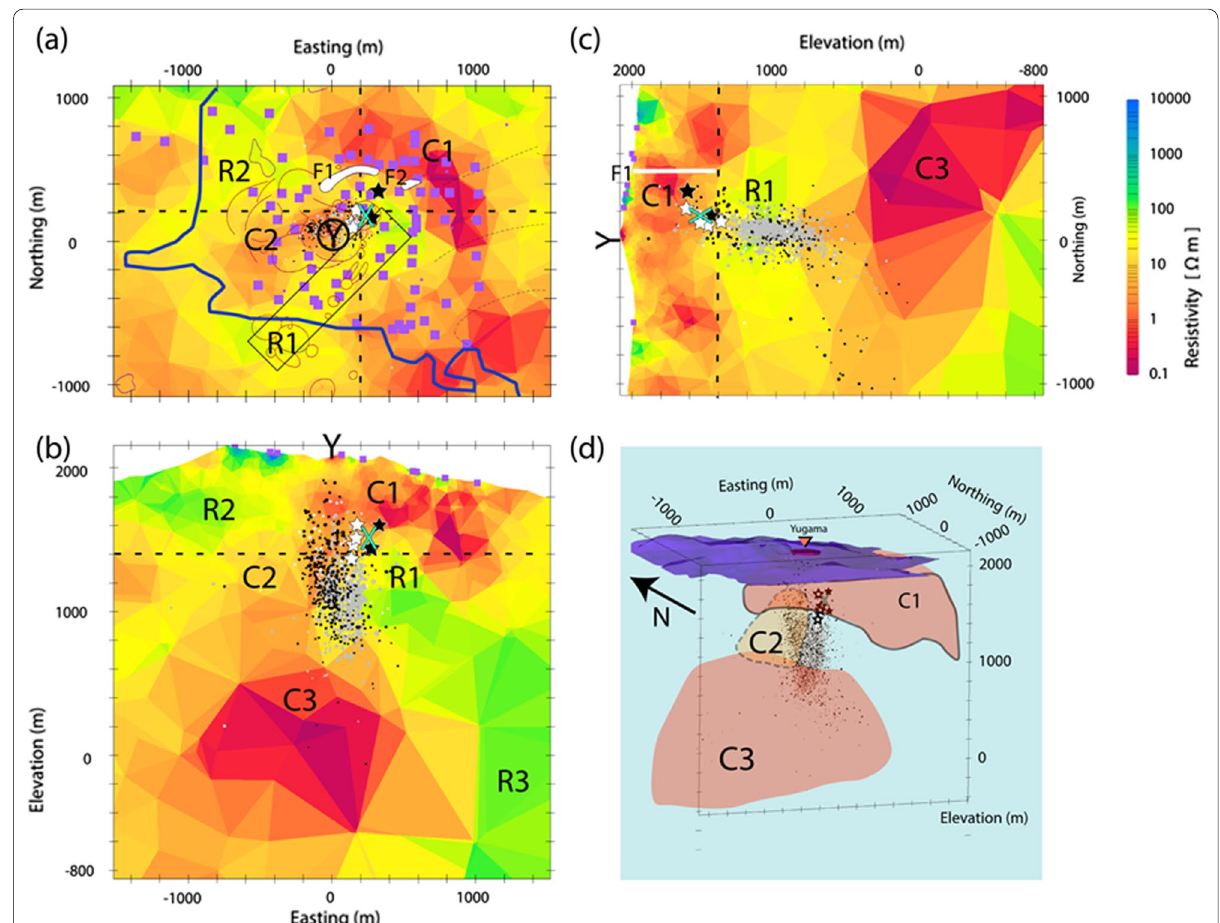
Fig. 4 a Depth slice at 1400 m ASL. The locations for W–E and S–N profiles for sections are shown by broken lines. b W–E and c S–N sections. The seismic hypocenters are mapped as dots on each map within 200 m tolerance normal to the sections. The white, black and gray dots denote hypocenters before, during and after the 2014 unrest, respectively. The shallow seismicity (black dots) going through the clay cap (C1) is evident during the 2014 unrest. The white and black stars denote the same as in Fig. 3. The blue X denotes the point pressure source locations for explaining the radial inflation of the edifice during the 2014 unrest (Terada et al. 2015). Two white masks with irregular shape in a denote the fumarole zone at the north of Yugama crater lake. The white line in c denotes the projection of fumarole zone F1 at 1400 m ASL. d The 3-D view of the three major conductors. The blue surface shows the topography. The dots denote seismicity as in a –